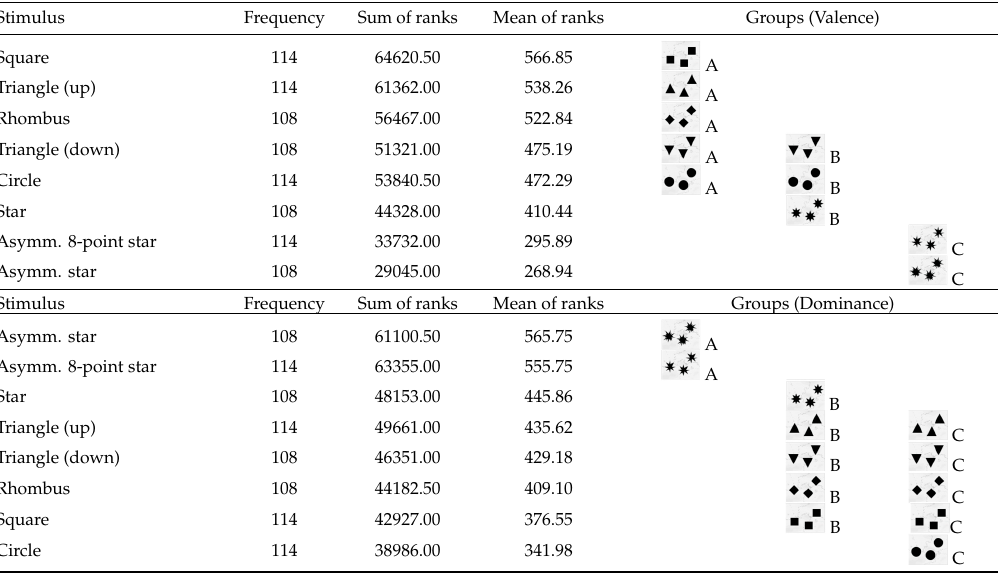
Table 4. Results of multiple pairwise comparisons of map stimulus set 2 indicating groups of similar valence and dominance.